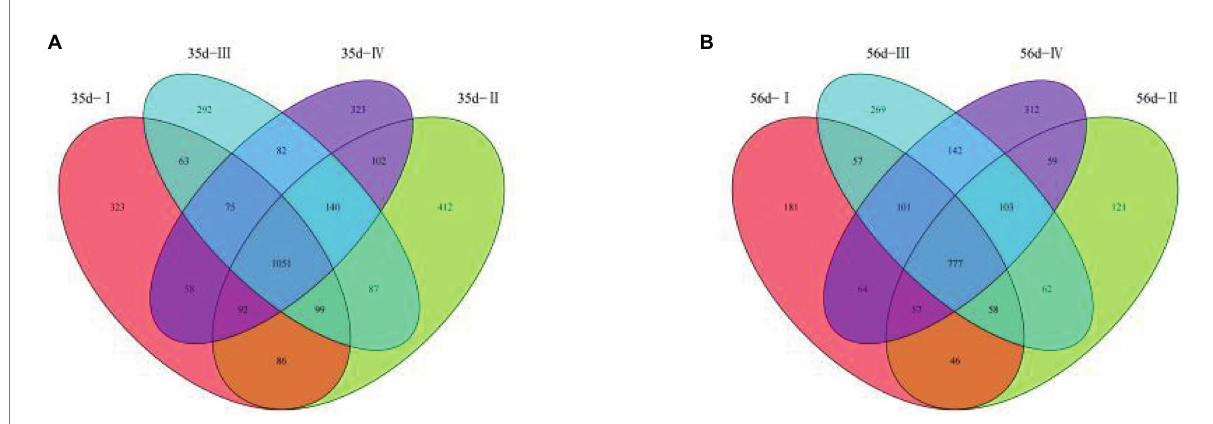
FIGURE 3 Analysis of Venn Diagram and Dilution Curve of Cecal Microorganism in broilers in different treatment groups. (A) Venn diagram for 35-day-old broilers; (B) Venn diagram for 56-day-old